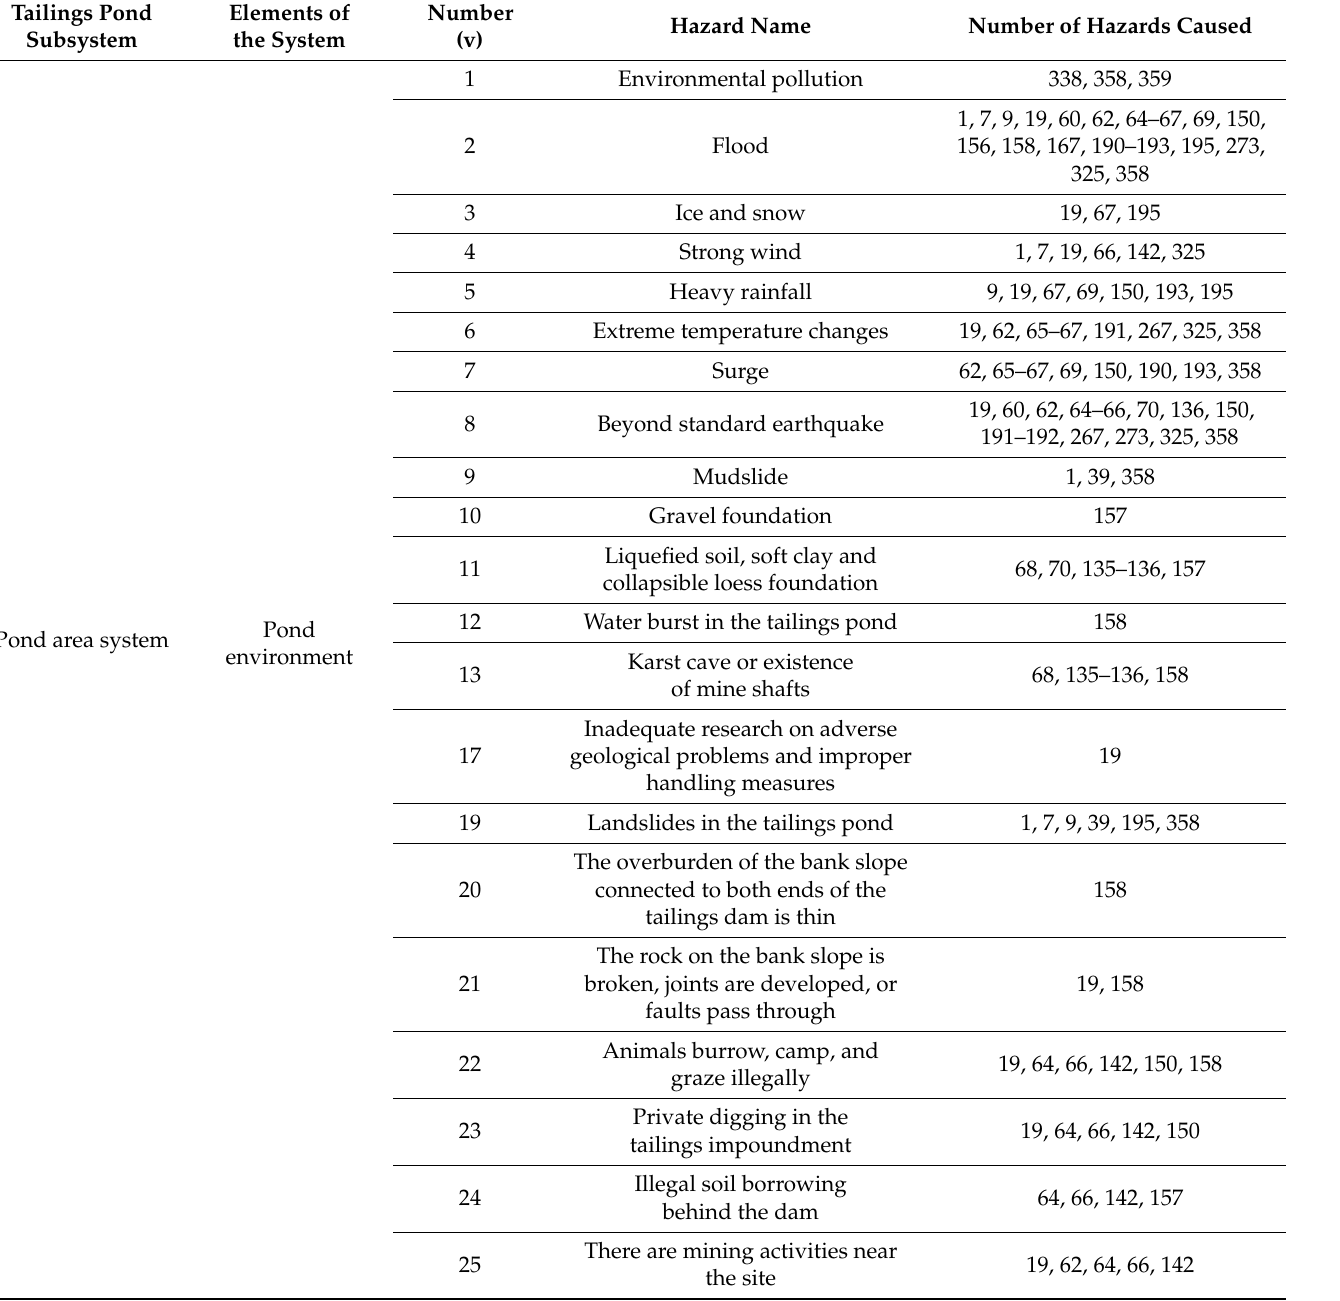
Table A1. List of reclamation hazards in tailings